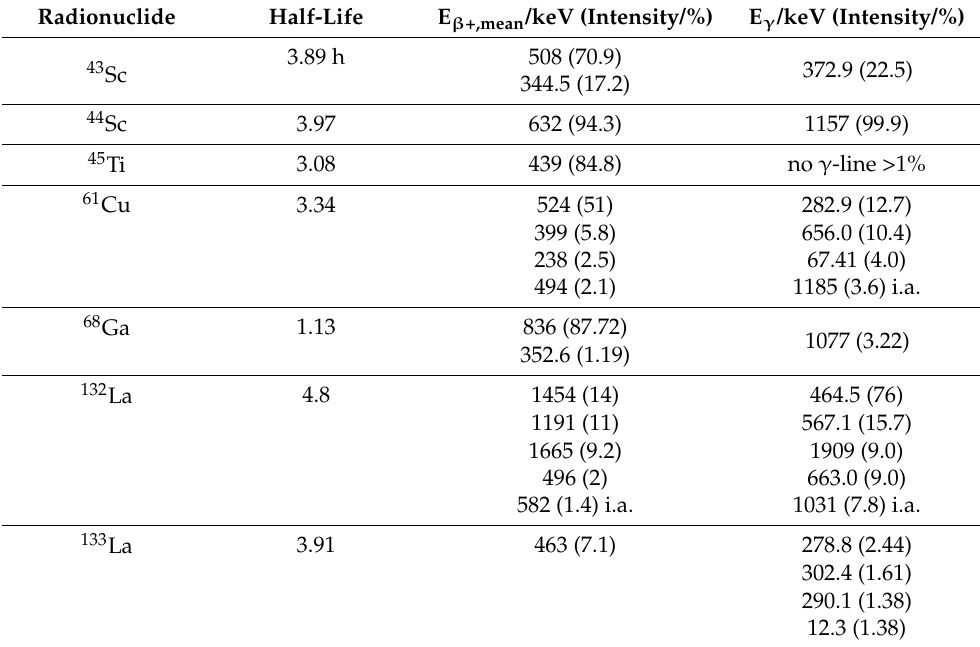
Table 1. Physical properties of short-lived β + -emitting radiometals suitable for PET imaging. Radionuclide Half-Life E β +,mean /keV